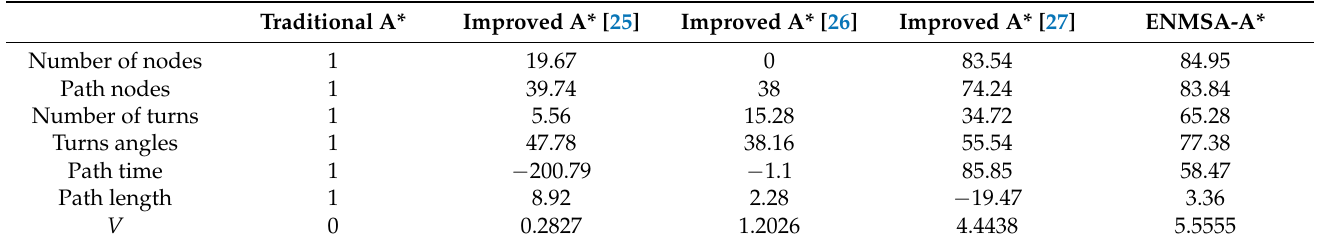
Figure 13. Comparison data of algorithm path planning simulation: ( a ) Number of nodes; ( b ) path Table 5. Percentage of performance reduction for each improved A* algorithm in the literature compared to the traditional A*